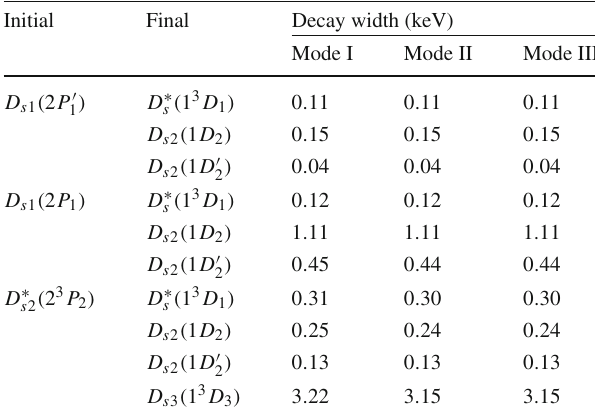
Table 5 Electric transition width for P → D γ processes, where P and D are P - and D -wave charmed-strange mesons, respectively Initial Final Decay width (keV) Mode I Mode II Mode